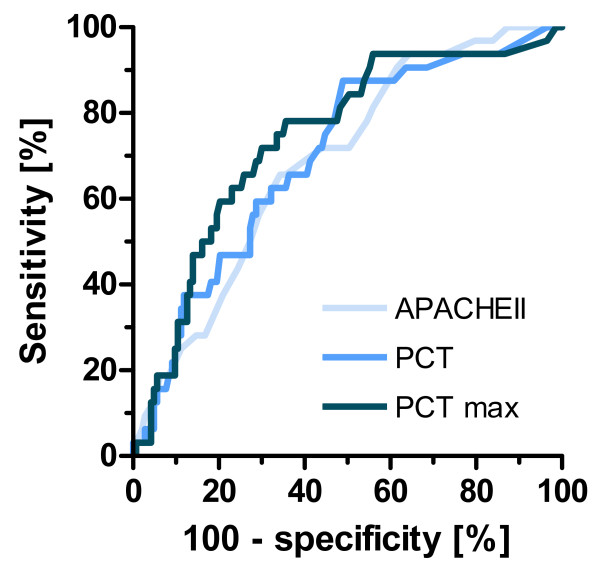
Receiver operator characteristic (ROC) curve for 28-day mortality prediction. Areas under the curve: maximum PCT 0.74 (95% CI: 0.65 to 0.83), initial PCT 0.70 (95% CI: 0.60 to 0.80), and APACHE II 0.69 (95% CI: 0.59 to 0.78).